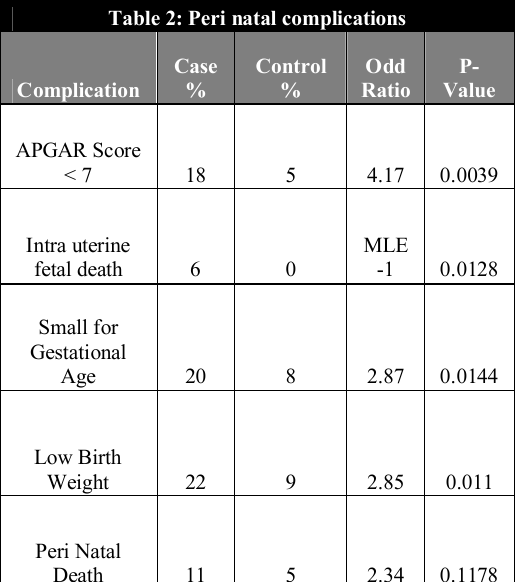
Table 2: Peri natal